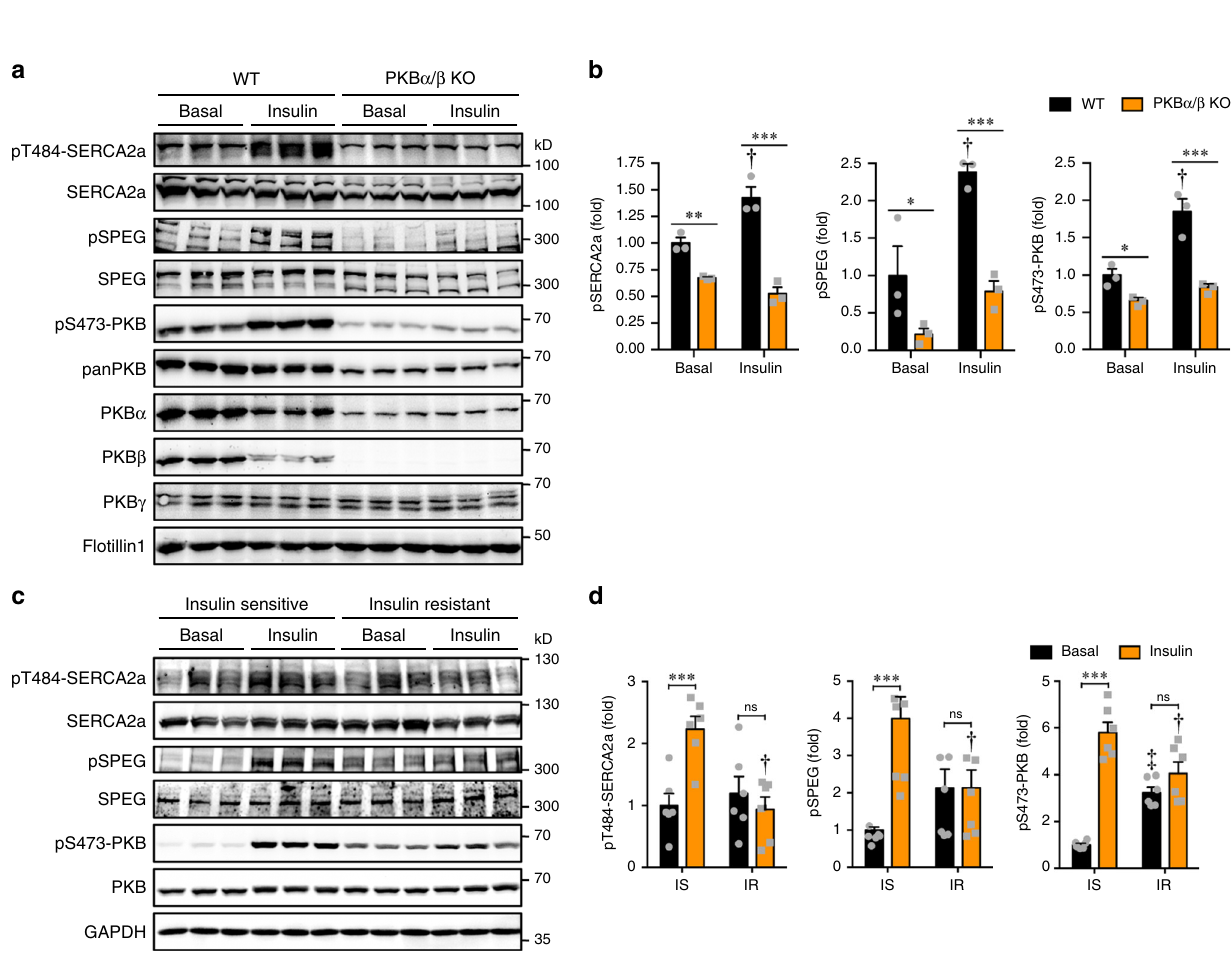
Fig. 5 Phosphorylation of PKB-SPEG – SERCA2a axis in insulin-resistant cardiomyocytes. a , b Phosphorylation of PKB, SPEG, and SERCA2a in WT or PKB α / β -KO primary cardiomyocytes stimulated with or without insulin. Phosphorylation of PKB, SPEG and SERCA2a was normalized with their respective total proteins, and quantitative data were shown in b . n = 3. c, d . Phosphorylation of PKB, SPEG and SERCA2a in insulin-sensitive or resistant H9C2 cardiomyocytes stimulated with or without insulin. H9C2 cardiomyocytes were differentiated for 7 days before insulin resistance was induced by prolonged treatment with 300 nM insulin for 24 h. Cells were then stimulated with or without insulin for 30 min. Representative blots were shown in c . Phosphorylation of PKB, SPEG and SERCA2a was normalized with their respective total proteins, and quantitative data were shown in d . n = 6. IS insulin sensitive, IR insulin-resistant. One-dagger (IS insulin vs IR insulin) indicates p < 0.01. One-diesis (IS basal vs IR basal) indicates p < 0.001. The data are given as the mean ± SEM. Statistical analyses were carried out using two-way ANOVA. One-asterisk indicates p < 0.05, two-asterisk indicates p < 0.01, and three-asterisk indicates p < 0.001. Source data are provided as a Source Data fi